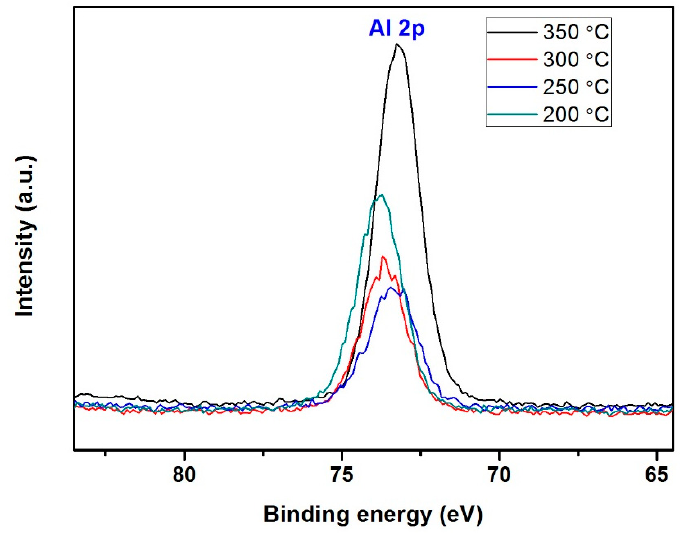
Figure 5. High resolution XPS spectra of Al elements under different deposition temperature, 200 °C, 250 °C, 300 °C and 350 °C.